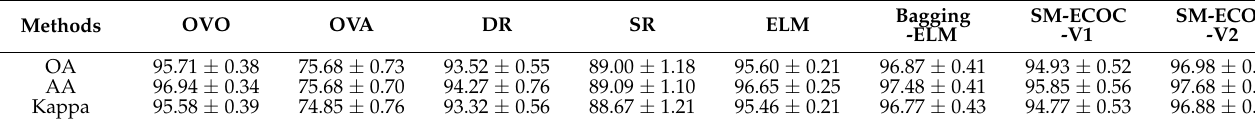
Table 6. Accuracy (%) of different classification models established based on all bands.